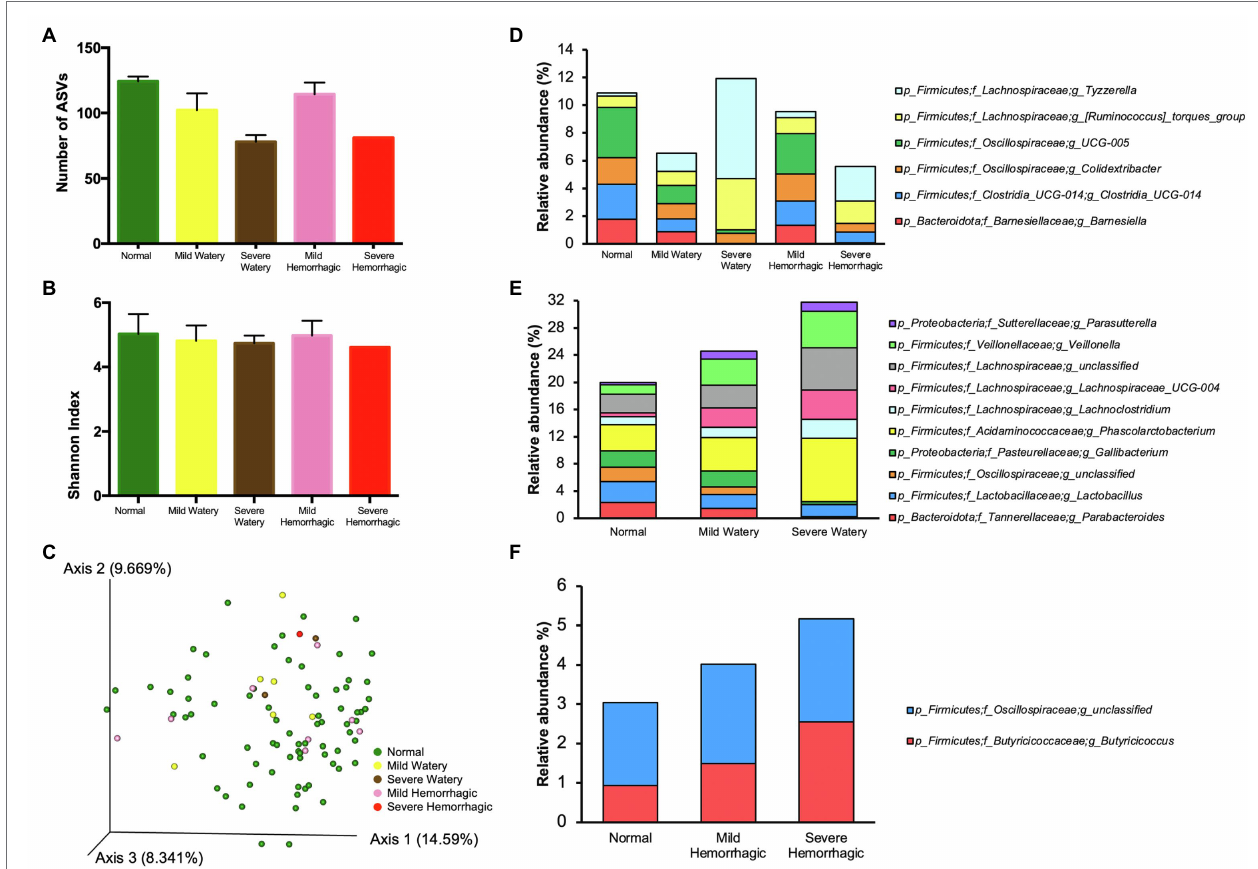
FIGURE 3 | The microbiota characteristics of feces with different morphologies. (A) The number of ASVs of feces with different morphologies. (B) The Shannon index of feces with different morphologies. (C) The PCoA plot based on Bray-Curtis distances comparing microbiota composition between feces with different morphologies. (D) The bacterial genera that either showed highest relative abundance or lowest relative abundance in normal feces compared with other morphologies. (E) The bacterial genera that were gradually changed with the severity of fecal watery morphology. (F) The bacterial genera that were gradually changed with the severity of hemorrhagic